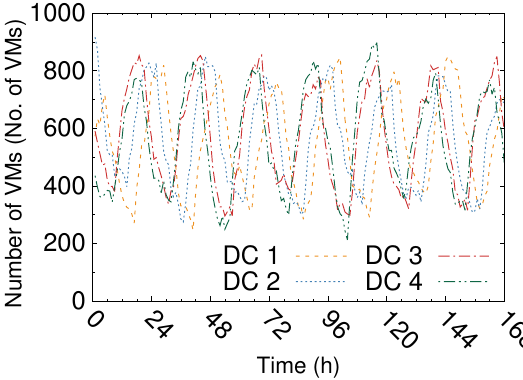
Figure 8. Number of VMs per DC versus time.